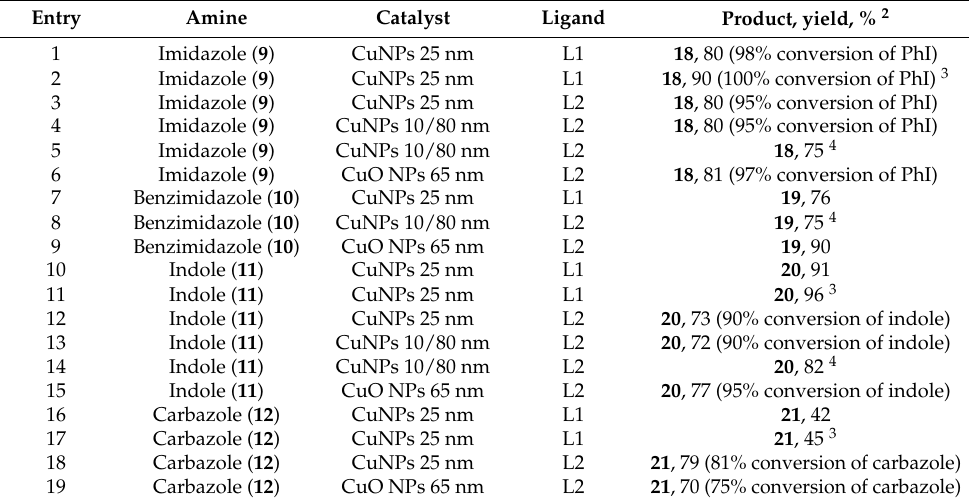
Table 5. Copper-catalyzed arylation of the amines 9–12 with iodobenzene 1 . Entry